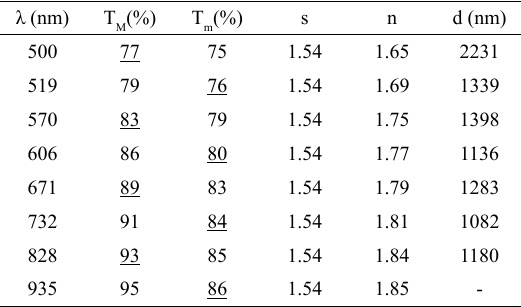
Table 6. The Manifacier’s calculations corresponding to the undoped ZnO sample deposited at 375°C using Eq.